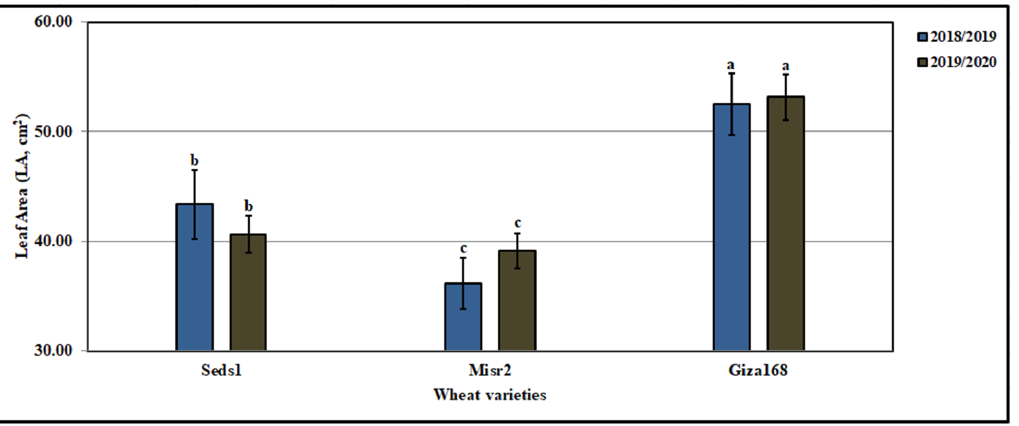
Figure 5. Influence of wheat varieties on leaf area (LA, cm 2 ) in clay loam soil in 2018/2019 and 2019/2020 seasons. Bars in the same years with a different letter indicate significant differences between treatments at p ≤ 0.01.